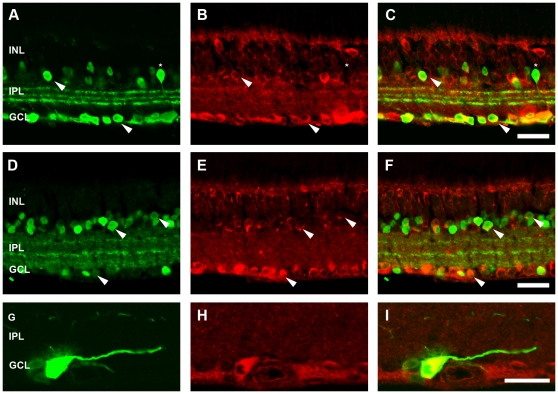
APP-immunoreactivity (IR) in the WT mouse retina colocalises with with calretinin positive- and GABA positive-amacrine cells, as well as ganglion cells.Immunohistochemistry on a transverse retinal section from an adult WT mouse for (A) amacrine cells labelled with Calretinin, and (B) APP-IR, showing (C) colocalisation. Immunohistochemistry for (D) GABAergic amacrine labelled with an antibody against GABA and (E) APP-IR, showing (F) colocalisation. Immunohistochemistry for (G) ganglion cells labelled with an antibody against GFP to localise YFP positive cells in the thy1-HYFP mouse and (H) APP-IR, showing (I) colocalisation. Arrows indicate examples of colocalisation, while * indicates a calretinin positive cell not labelled for APP-IR. Inner nuclear layer (INL), inner plexiform layer (IPL) and ganglion cell layer (GCL). Scale, 50 microns.